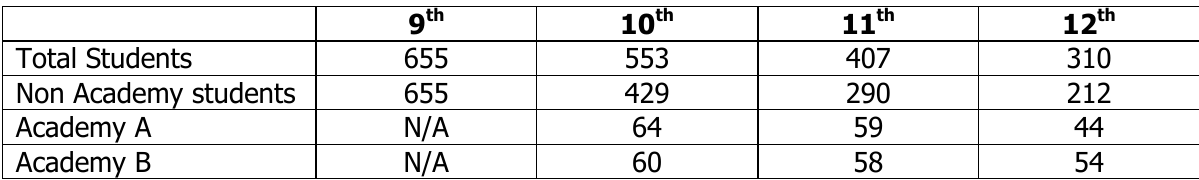
Holding Power of NHS Class of